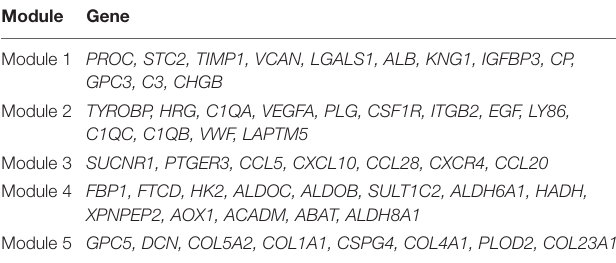
TABLE 2 | Genes in each functional module identified in the PPI network. Module Gene Module 1 PROC, STC2, TIMP1, VCAN, LGALS1, ALB, KNG1, IGFBP3, CP, GPC3, C3,